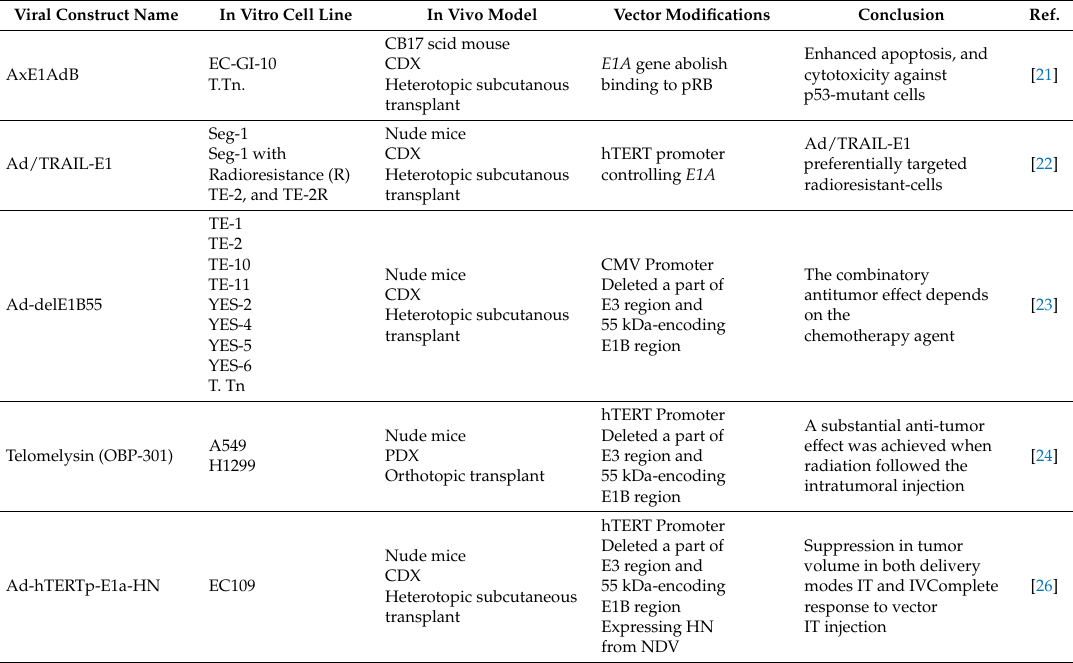
Table 3. Preclinical research in esophageal